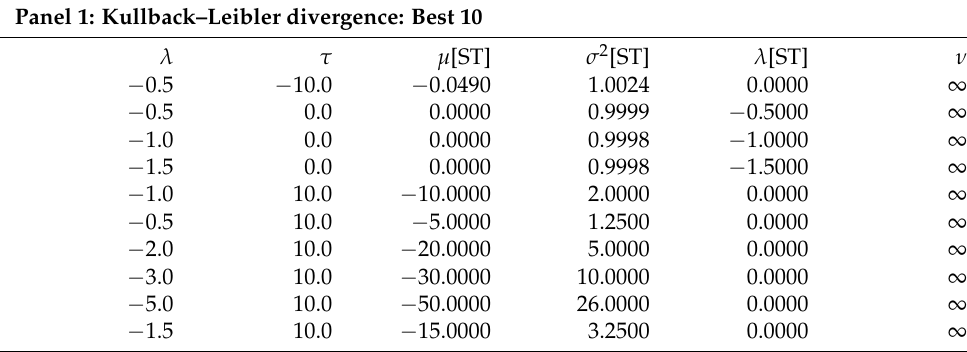
Table 11. Divergence between ESN ST density